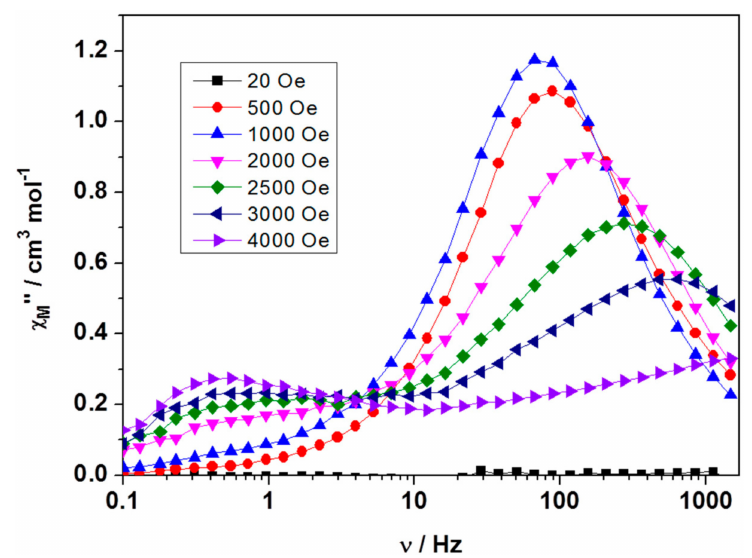
Figure 9. χ M ” vs. ac frequency plots for 1 at the indicated dc fields showing the optimal field of 1000 Oe. Note that the low frequency maxima in high dc fields is due to quantum tunnelling of the magnetisation and can be